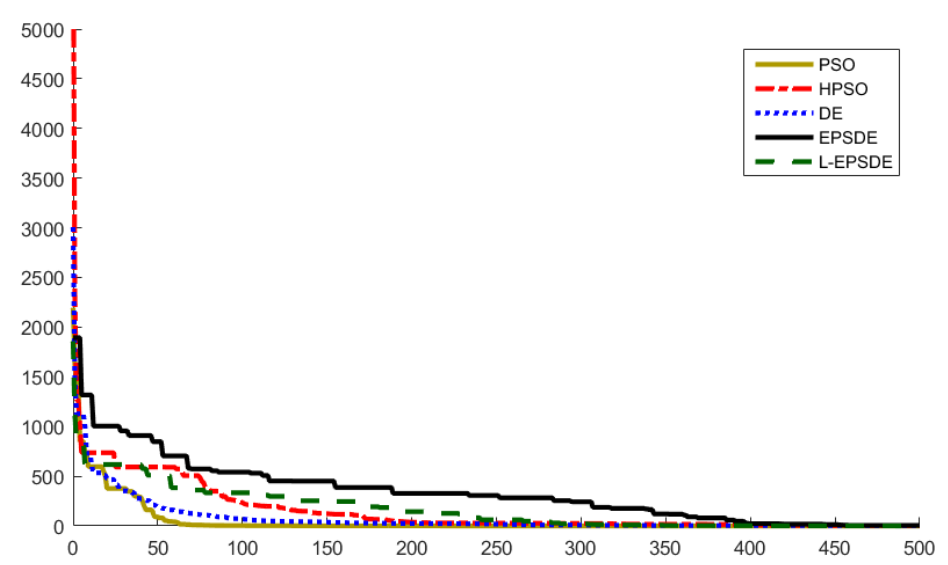
Figure 21. Trajectory of the coupler point of Case 5.